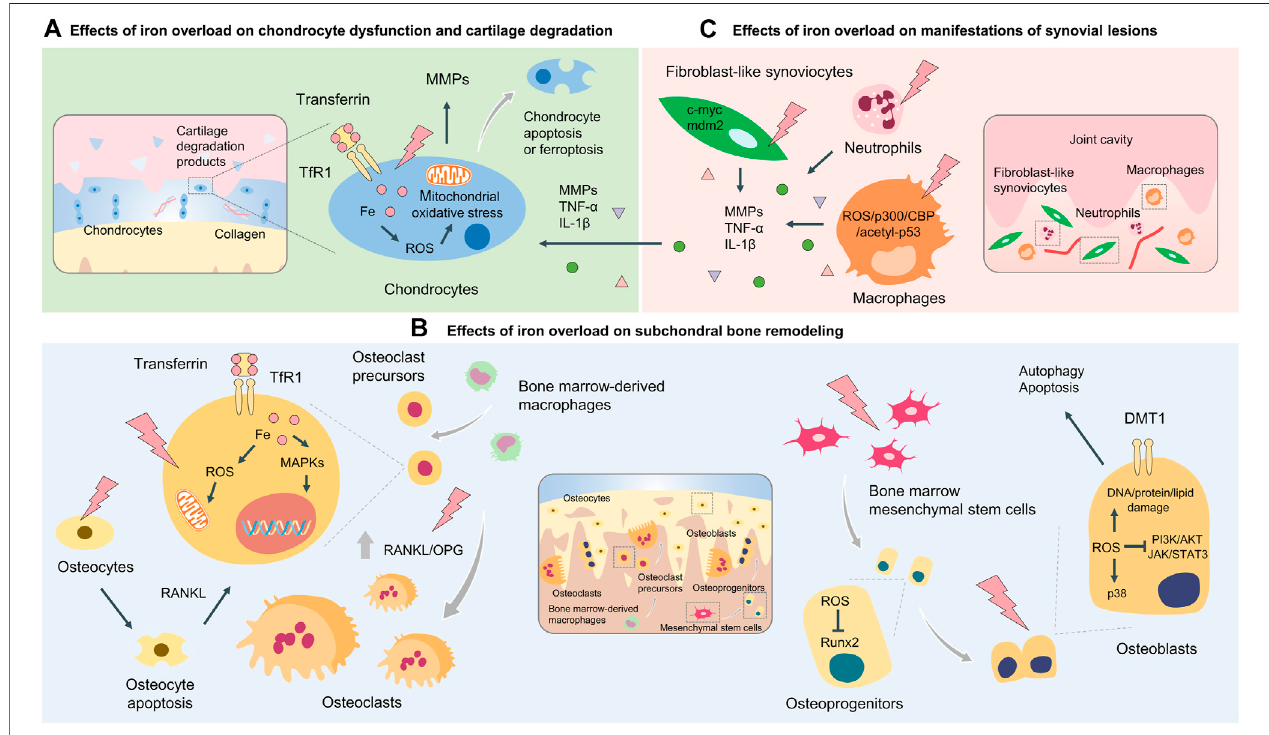
FIGURE 2 | Cellular and molecular mechanisms of iron overload involved in OA. Cellular and molecular mechanisms of iron overload involved in OA include the effects of iron overload on chondrocyte dysfunction and cartilage degradation (A) subchondral bone remodeling process which osteoclasts and osteoblasts coordinately regulate (B) , and manifestations of synovial lesions mediated by macrophages, fi broblast-like synoviocytes, and neutrophils (C) .